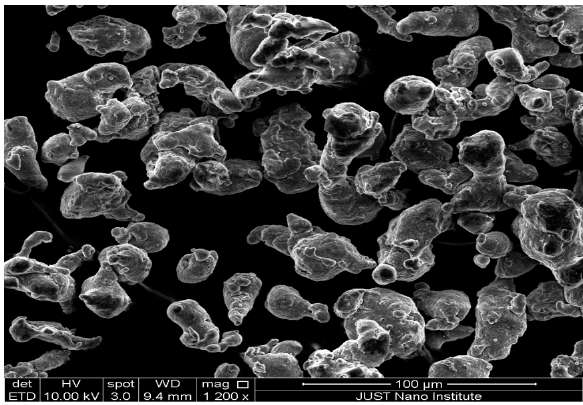
Figure 1: SEM micrograph of elongated sub-angular Al